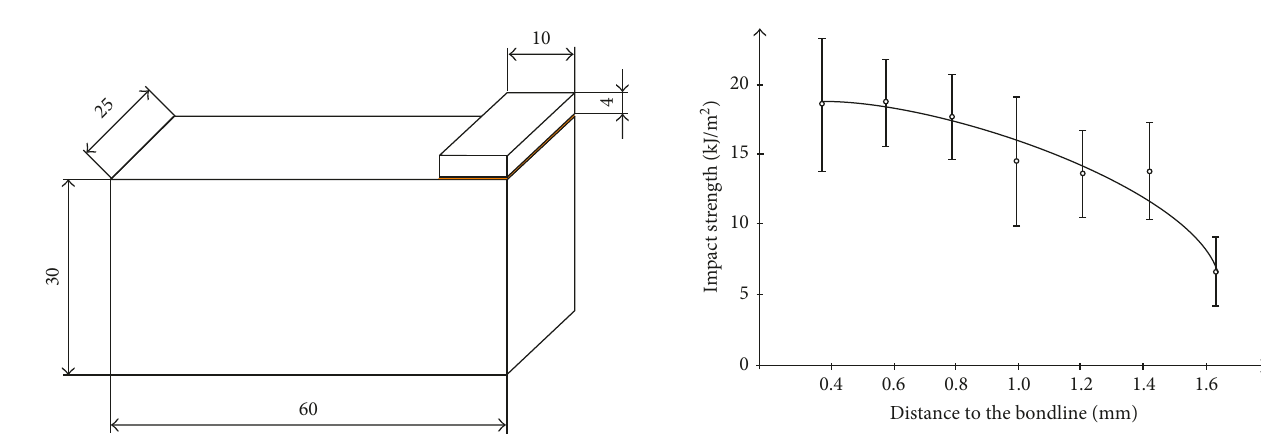
Figure 3: Impact strength in the function of the distance of ap- plying the impact load to the bondline.